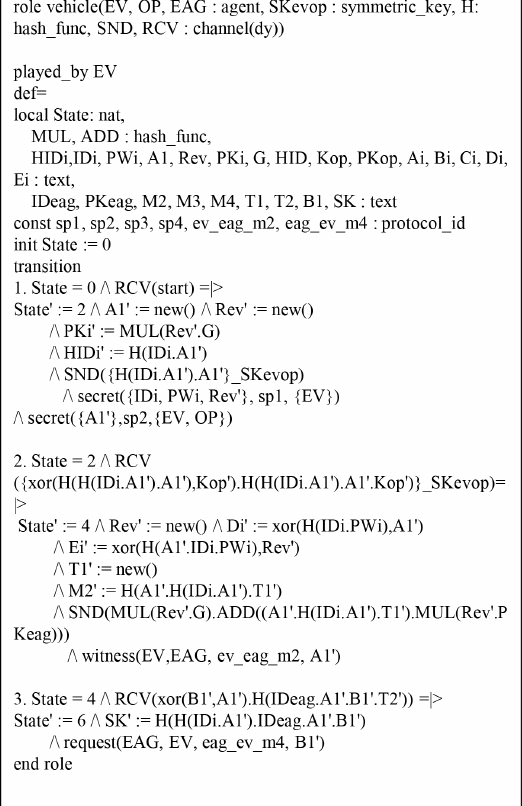
Figure 9. Specification of the electronic